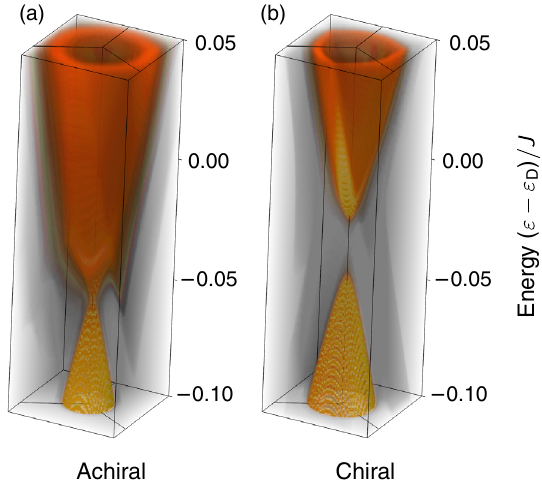
FIG. 4. Tomographic cut of the interaction-renormalized mag- non Dirac cones in (a) achiral and (b) chiral magnets. Black transparent (orange opaque) color indicates the zero (maximal) ε Þ . The momentum and energy window spectral function A k ð shown here coincides with that marked by a red rectangle in =J ¼ 0 . 15 , Fig. 2. The parameters read S ¼ 1 , B=J ¼ 1 , and (a) D z (b) D=J ¼ 0 . 15